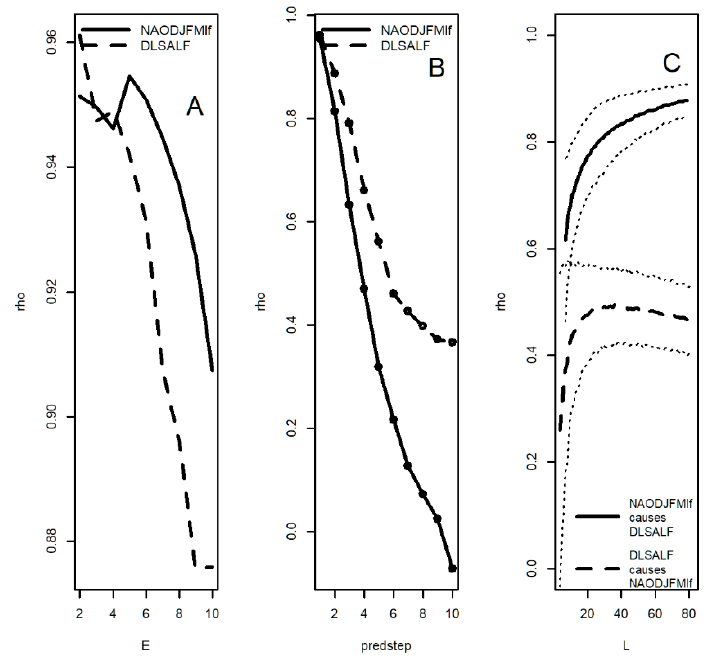
Figure 13. Convergent cross mapping results for the low frequency NAO series for December- March (NAODJFMlf) and the low frequency 1 ◦ gridded Desert Locust series 1930–2014 (DLSAlf). ( A ). Showing use of maximum values of correlation coefficient rho ( ρ ) to estimate the embedding dimension (E) of each series; ( B ) showing decreasing rho with increasing number of prediction steps to confirm non ‐ linearity and ( C ) showing increasing rho with increasing library length (L) for the hypothesis that NAODJFMlf causes DLSAlf ( p = 0.0007) and for the converse (DLSAlf causes NAODJFMlf, p = 0.29).